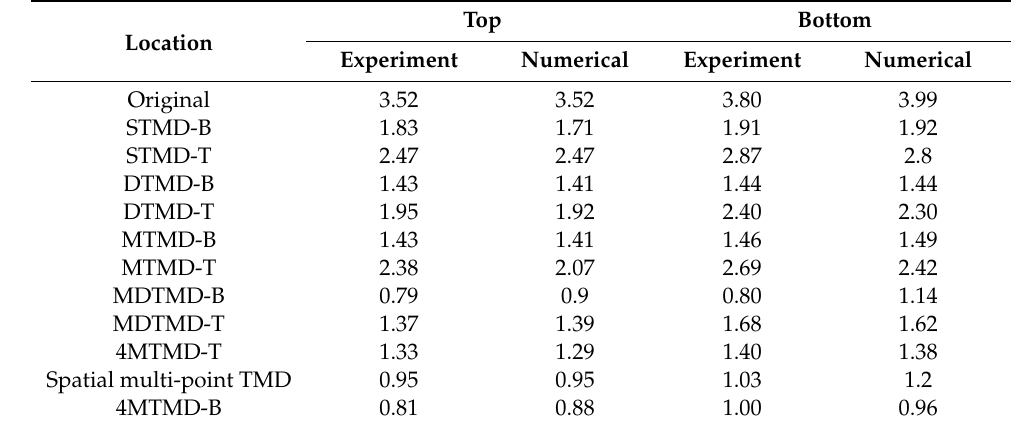
Table 6. Comparison of experimental and numerical acceleration responses ( g ).